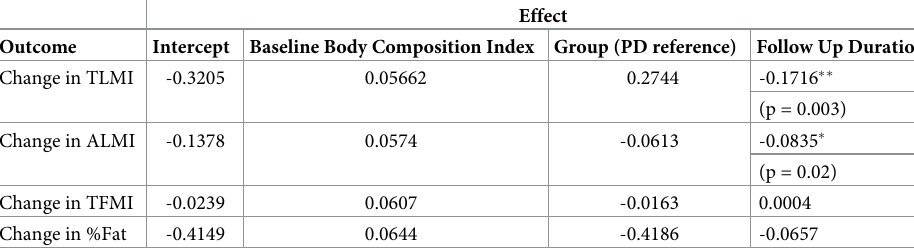
Table 3. Multivariable mixed model analysis of change in body compositions and baseline body compositions, disease group and follow up